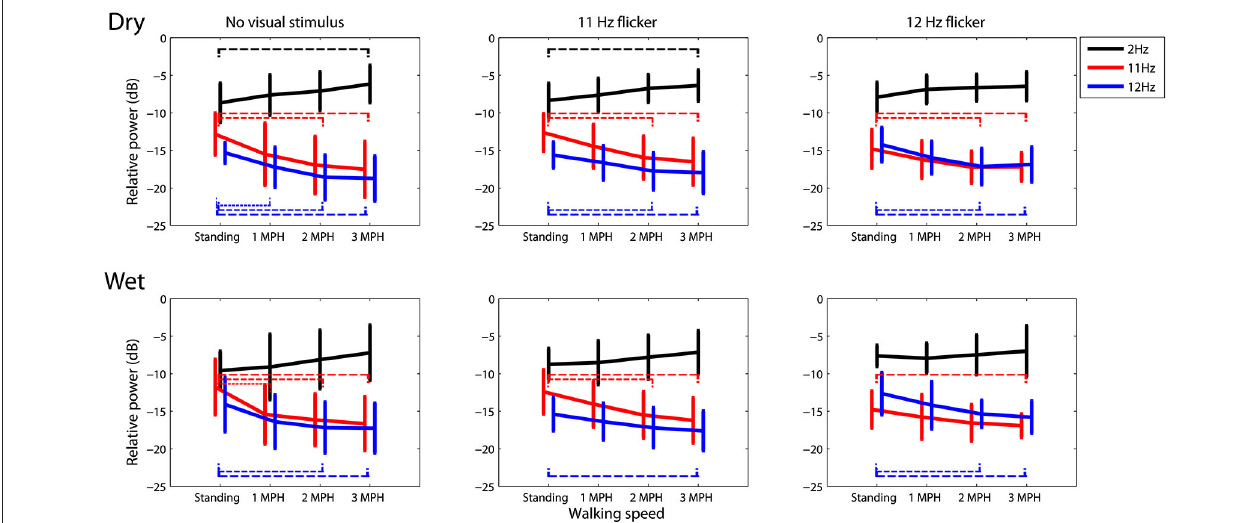
FIGURE 3 | The dry-wet electrode comparison in spectral fluctuations at 2, 11, and 12 Hz while subjects standing or walking on the treadmill with or without the presence of visual flickers (11 or 12 Hz) . The thin dash line indicates the significant difference between speeds ( p < 0.05), whereas the error bars represent the standard deviation of the